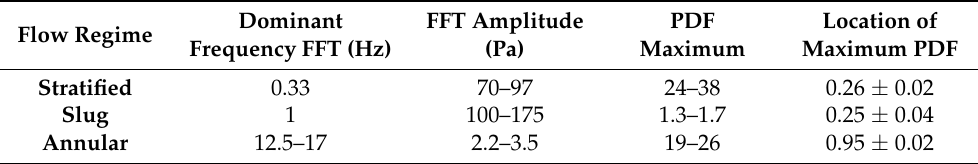
Figure 10. Fast Fourier Transform of the dynamic pressure signals of different flow regimes with normalized FFT magnitude. Table 4. Flow regime identification criteria based on the PDF and FFT of pressure